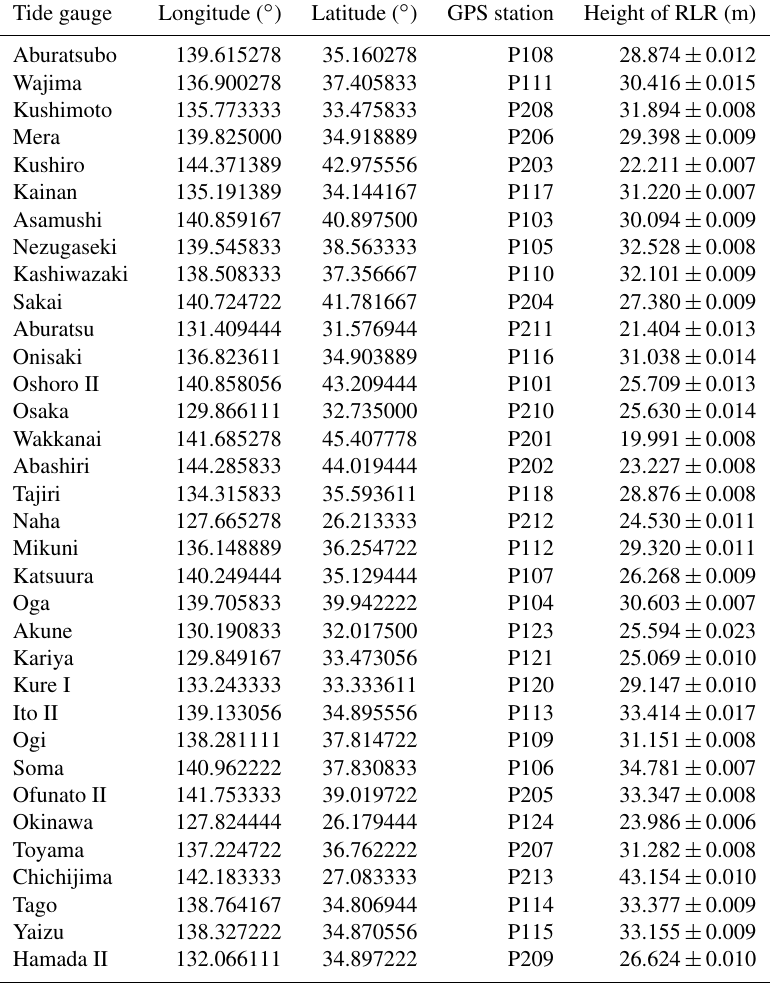
Table A1. Information of 34 tide gauge stations and joint GPS stations around